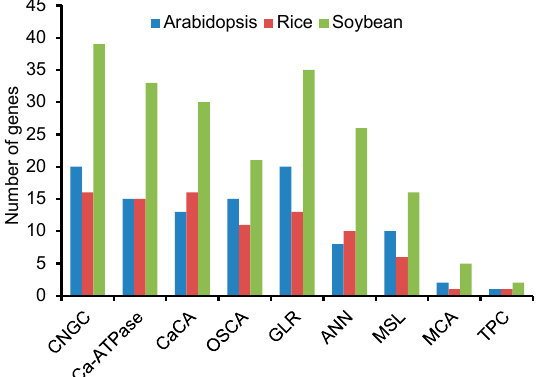
Figure 1. The number of genes encoding diverse Ca 2 + transport protein families in Arabidopsis , rice, and soybean.